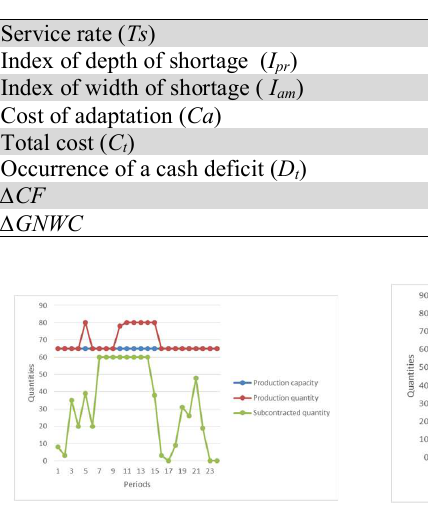
Fig. 4. Production in Case 1 Fig. 5. Production in Case 2 Fig. 6. Production in Case